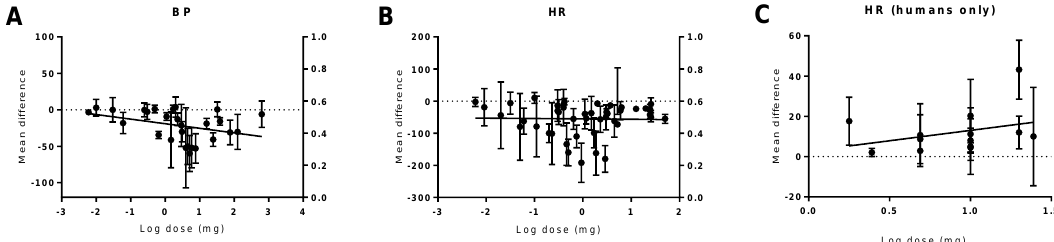
Figure 7. The effect of different THC doses on haemodynamic responses in vivo . The mean difference (MD) in animals' blood pressure (BP, ( A )), animals' heart rate (HR, ( B )), or heart rate (in humans only) ( p = 0.01) (HR, ( C )) is plotted against the log dose (mg) for each study. Error bars represent 95% confidence intervals (CI). Near-significant and significant dose-dependent effects on the blood pressure in animals ( p = 0.07) and on the HR in humans ( p = 0.01).